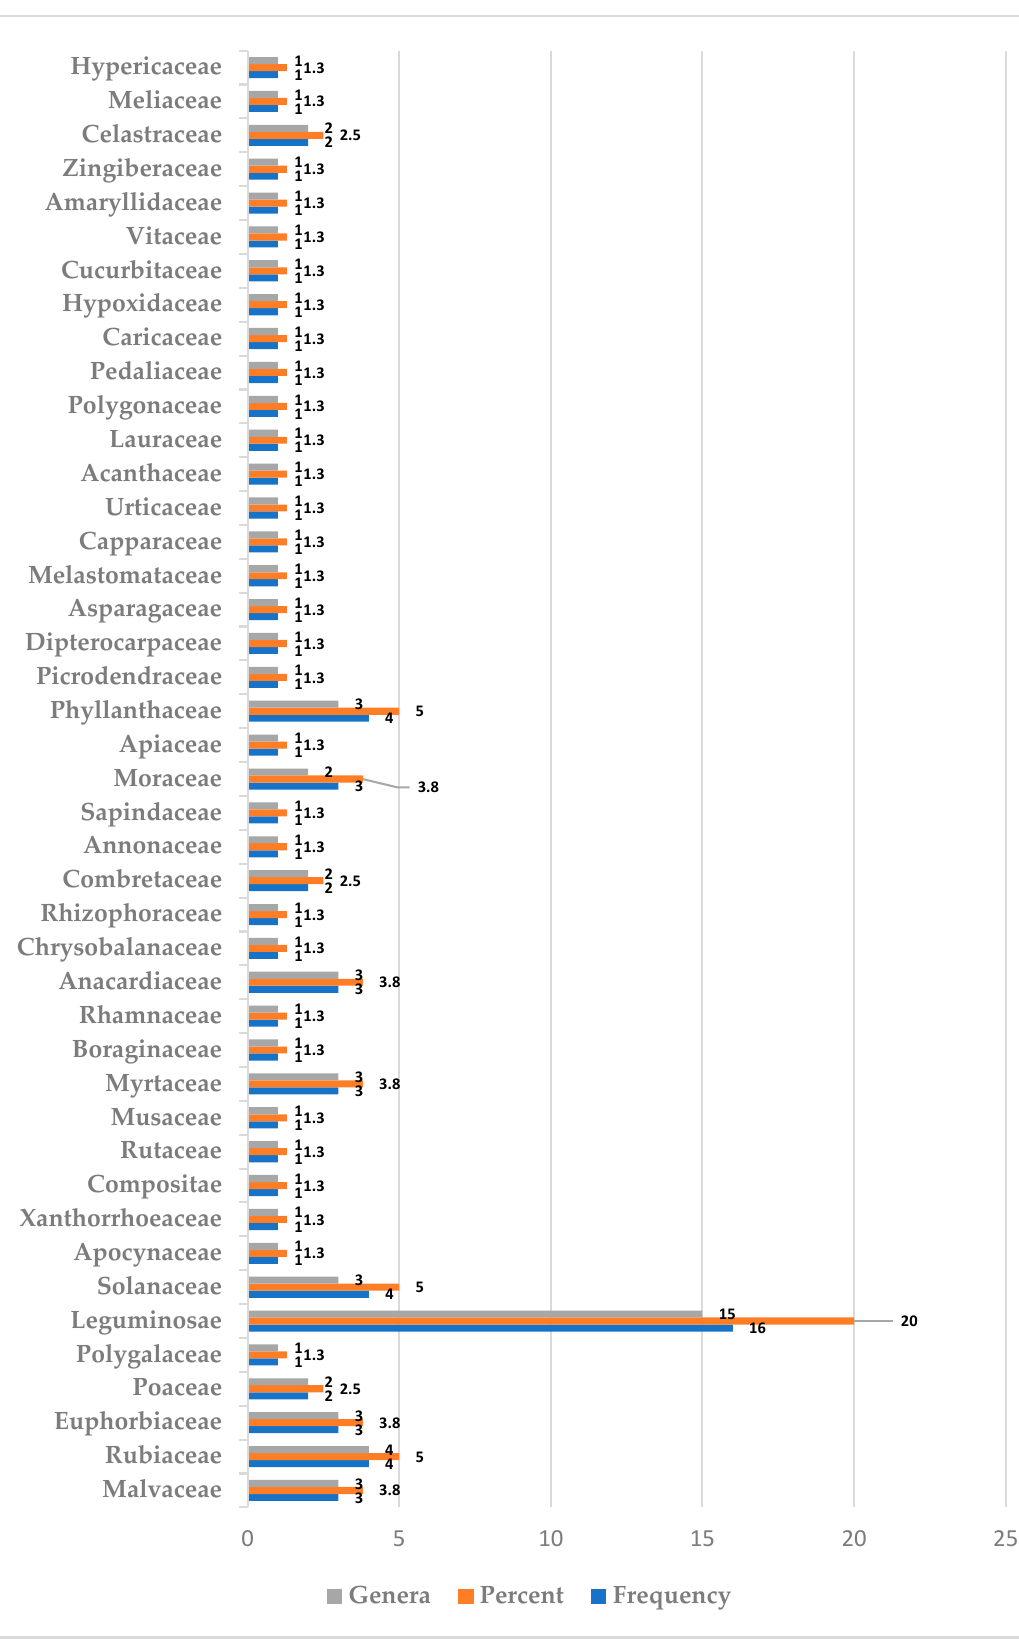
Figure 2. Medicinal plant families and their genera.